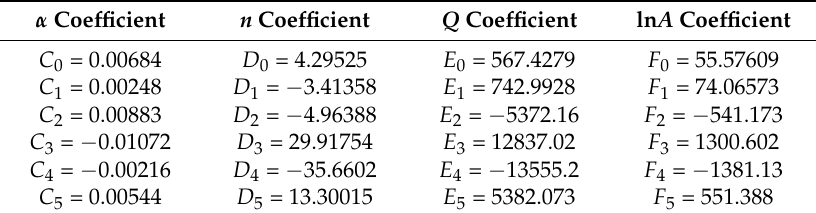
Table 1. Polynomial fitting results of material constants ( α , n , Q , and ln A ).